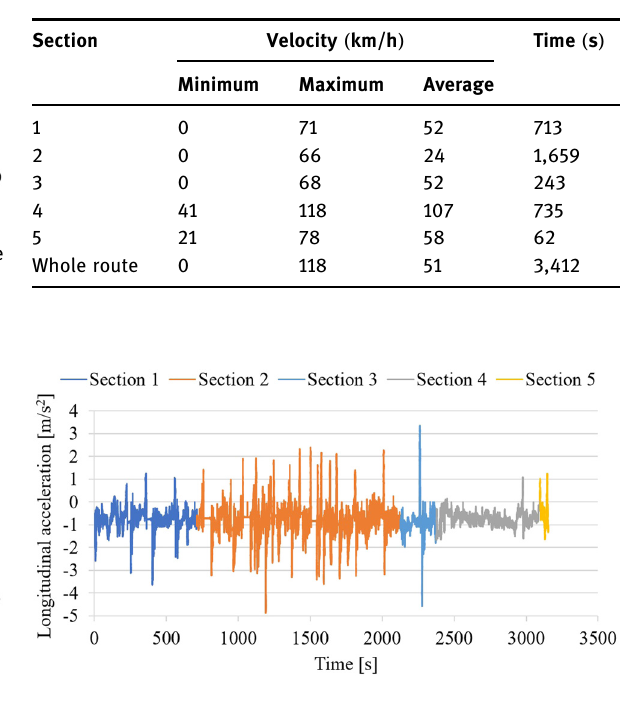
Figure 7: Longitudinal accelerations – morning drive.